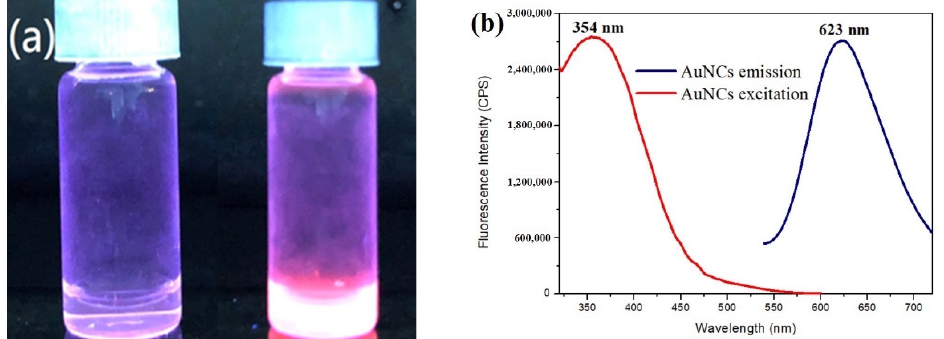
Figure 2. ( a ) The image of aqueous solutions of newly synthesized glutathione-Au NCs under UV- box detection. Two experiments were carried out, in the presence (right), and absence (left) of Ag NPs, respectively. A bright red color was observed in the solution on the right bottle, and the solu- tion in the left bottle was colorless. ( b ) The excitation (red line) and emission (black line) spectra of the synthesized Au NCs.